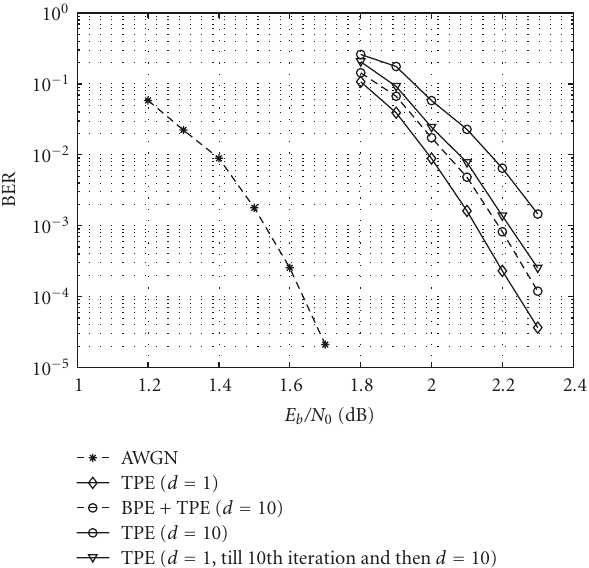
Figure 7: Performance of the low complexity receiver discussed in Section 7 under phase noise with σ Δ = 2 ◦ per